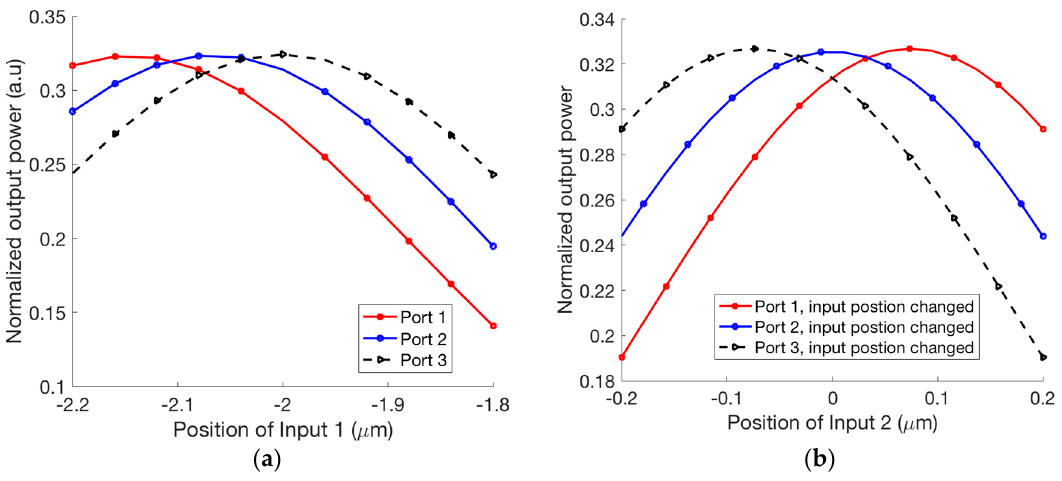
Figure 2. Normalized output powers for different positions of ( a ) input port 1 and ( b ) input port 2.